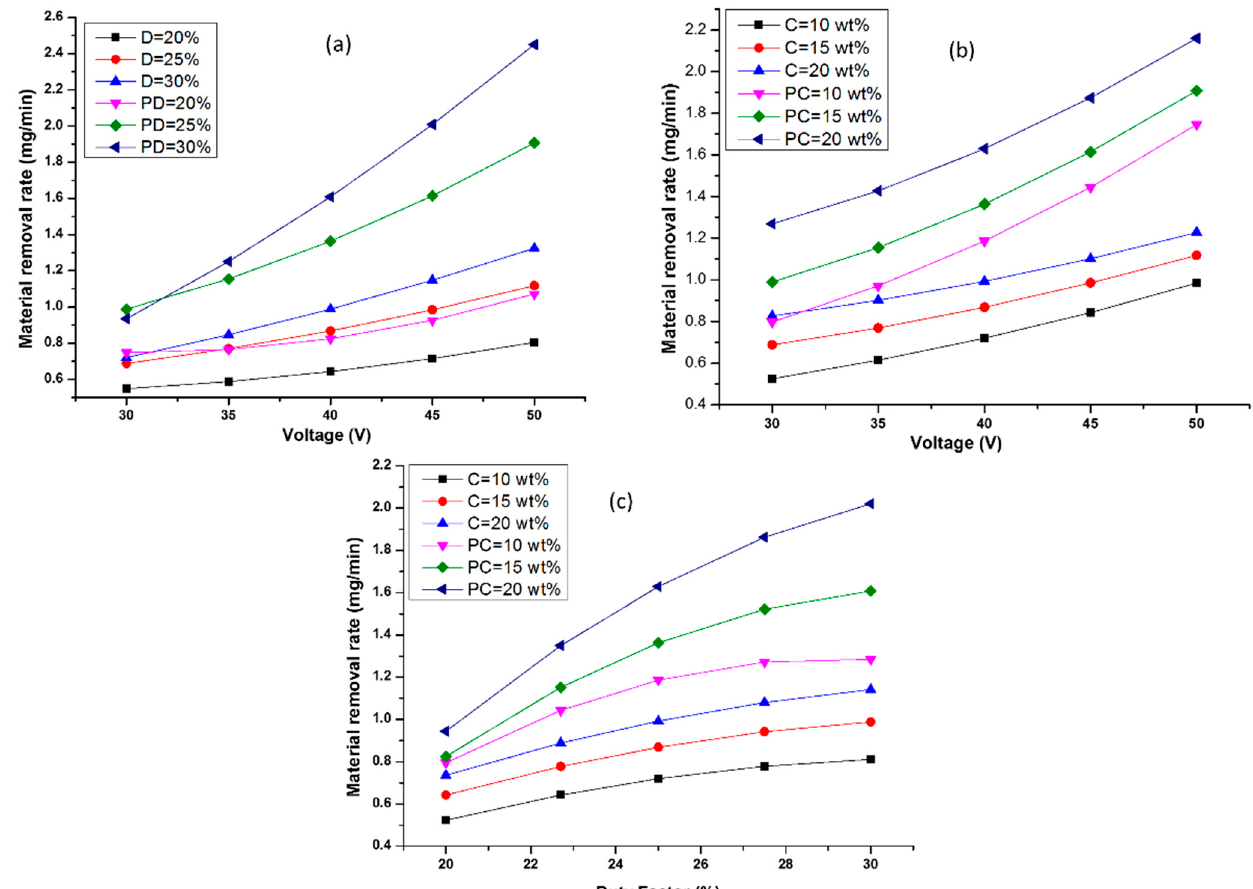
Figure 3. Impact of voltage (V) on MRR ( a ) at D and PD ( b ) at variable C and PC. Effect of duty factor on MRR ( c ) at various C and PC. Note: D: Duty factor, C: Concentration of working fluid at MECDM process and PD and PC are duty factor and concentration at PMECDM.